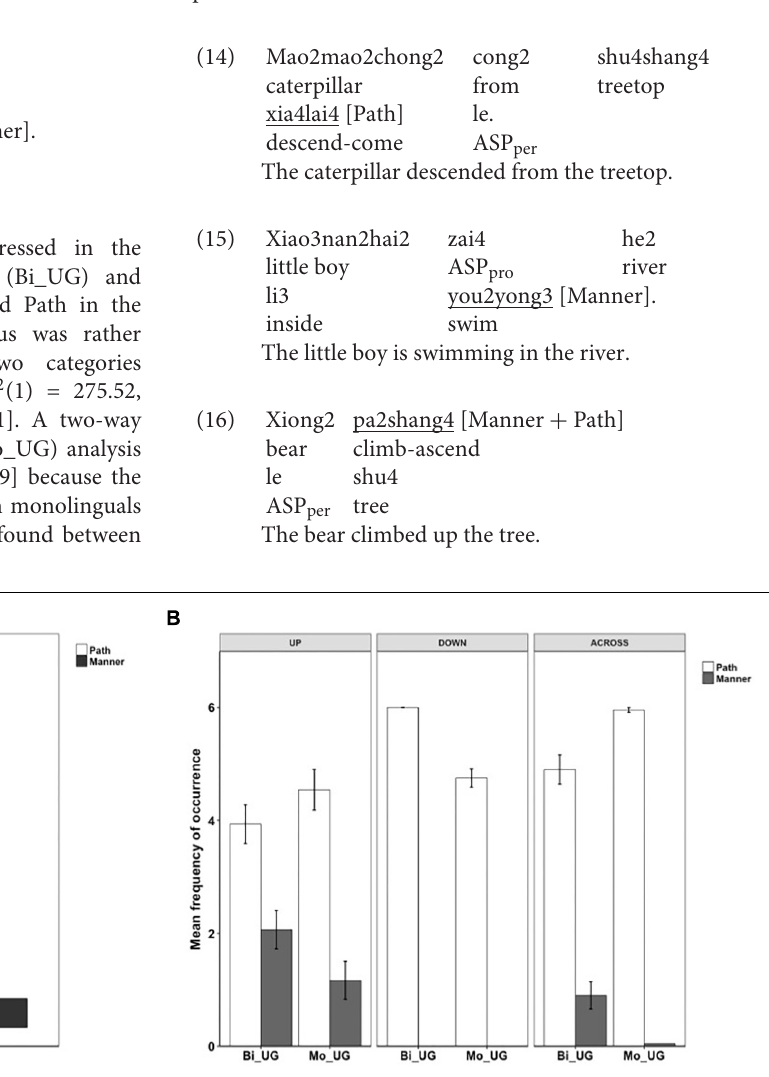
FIGURE 1 | Information in the verb locus in